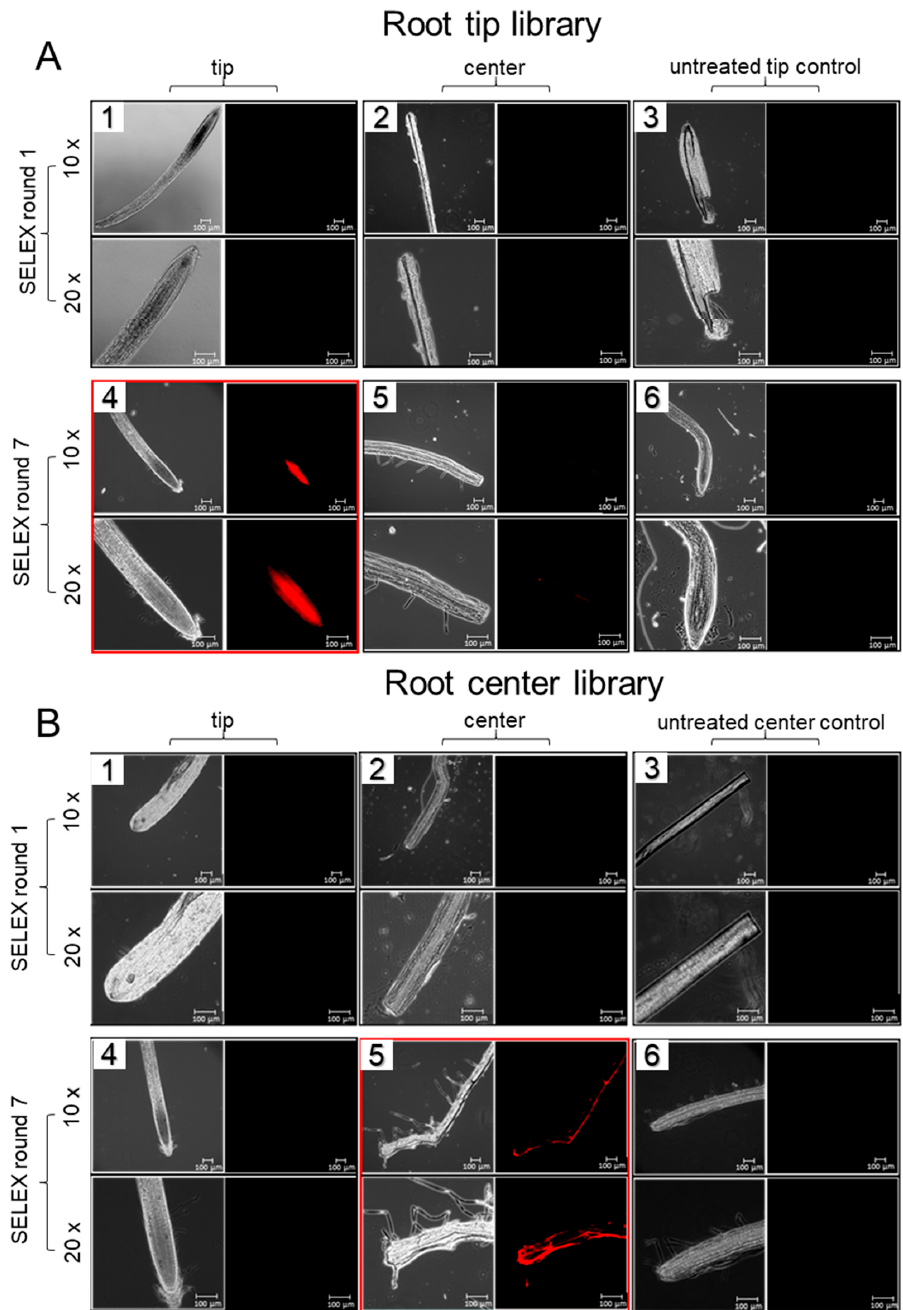
Figure 2. Visualization of the specific fluorescence labeling of A. thaliana root zones by Cy5-labeled root tip and root center aptamer libraries (excitation: 635 nm) using fluorescence and light-transmitting filters at 10×/20× magnitudes. In the process, the aptamers were added to the dedicated and opposite target sites, and, furthermore, the targets without aptamer treatments are shown as controls. ( A ) The target sites with root tip aptamers are displayed, and in ( B ), those with root center aptamers are shown. The upper panel shows the libraries of the first FluRoot-SELEX round and the lower panel represents the seventh round. Plants used for the analyses were cultivated for 12–14 days, and all experiments were performed using 10 pmol aptamers. Microscopy was performed using a Leica DMi8 coded (Leica Microsystems CMS GmbH, Wetzlar, Germany) under transmitted light and using the Y5 filter (excitation: 590–650 nm and emission: 662–738 nm) for fluorescence